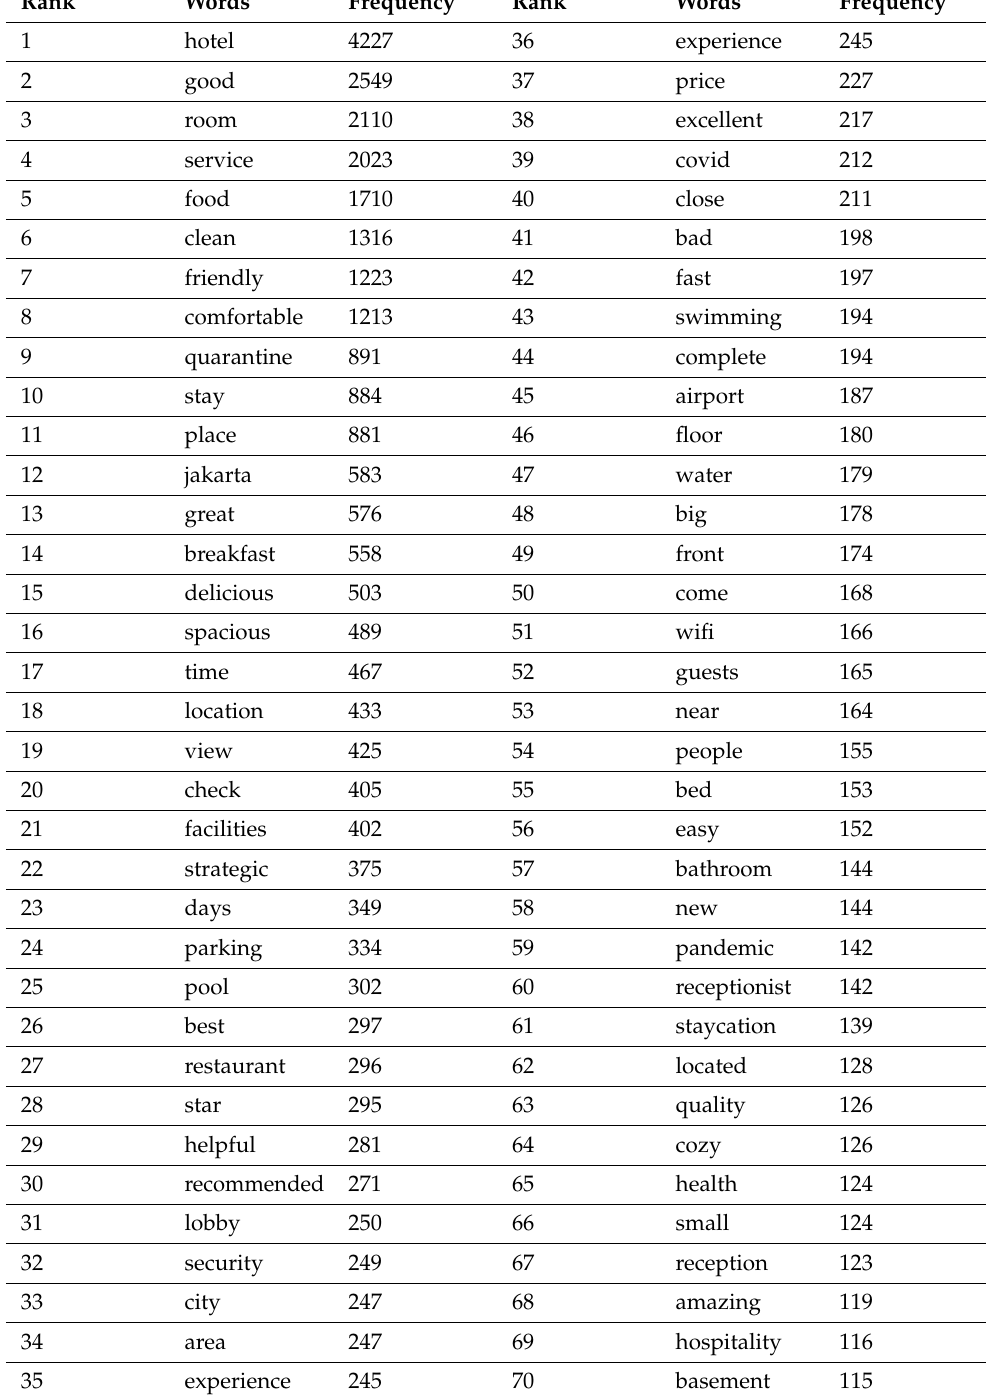
Table 4. Frequency of Top Keywords for Indonesia Quarantine